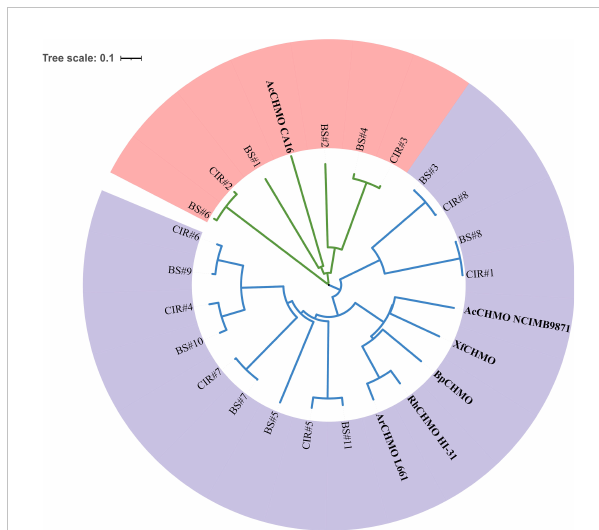
FIGURE 5 Phylogeny of CHMOs in MCH-consuming bacteria. CIR, CHMOs annotated in genus C1-B045 derived from the Central Indian Ridge; BS, CHMOs annotated in genus C1-B045 derived from the Bohai Sea; AcCHMO CA16, CHMO of Acinetobacter calcoaceticus CA16; RhCHMO HI-31, CHMO of Rhodococcus sp. HI-31; AcCHMO NCIMB9871, CHMO of Acinetobacter calcoaceticus NCIMB9871; XfCHMO, CHMO of Xanthobacter fl avus ; BpCHMO, CHMO of Brachymonas petroleovorans ; ArCHMO L661, CHMO of Arthrobacter sp. L661. Class I of CHMOs is highlighted in light purple; The class II of CHMOs is highlighted in light